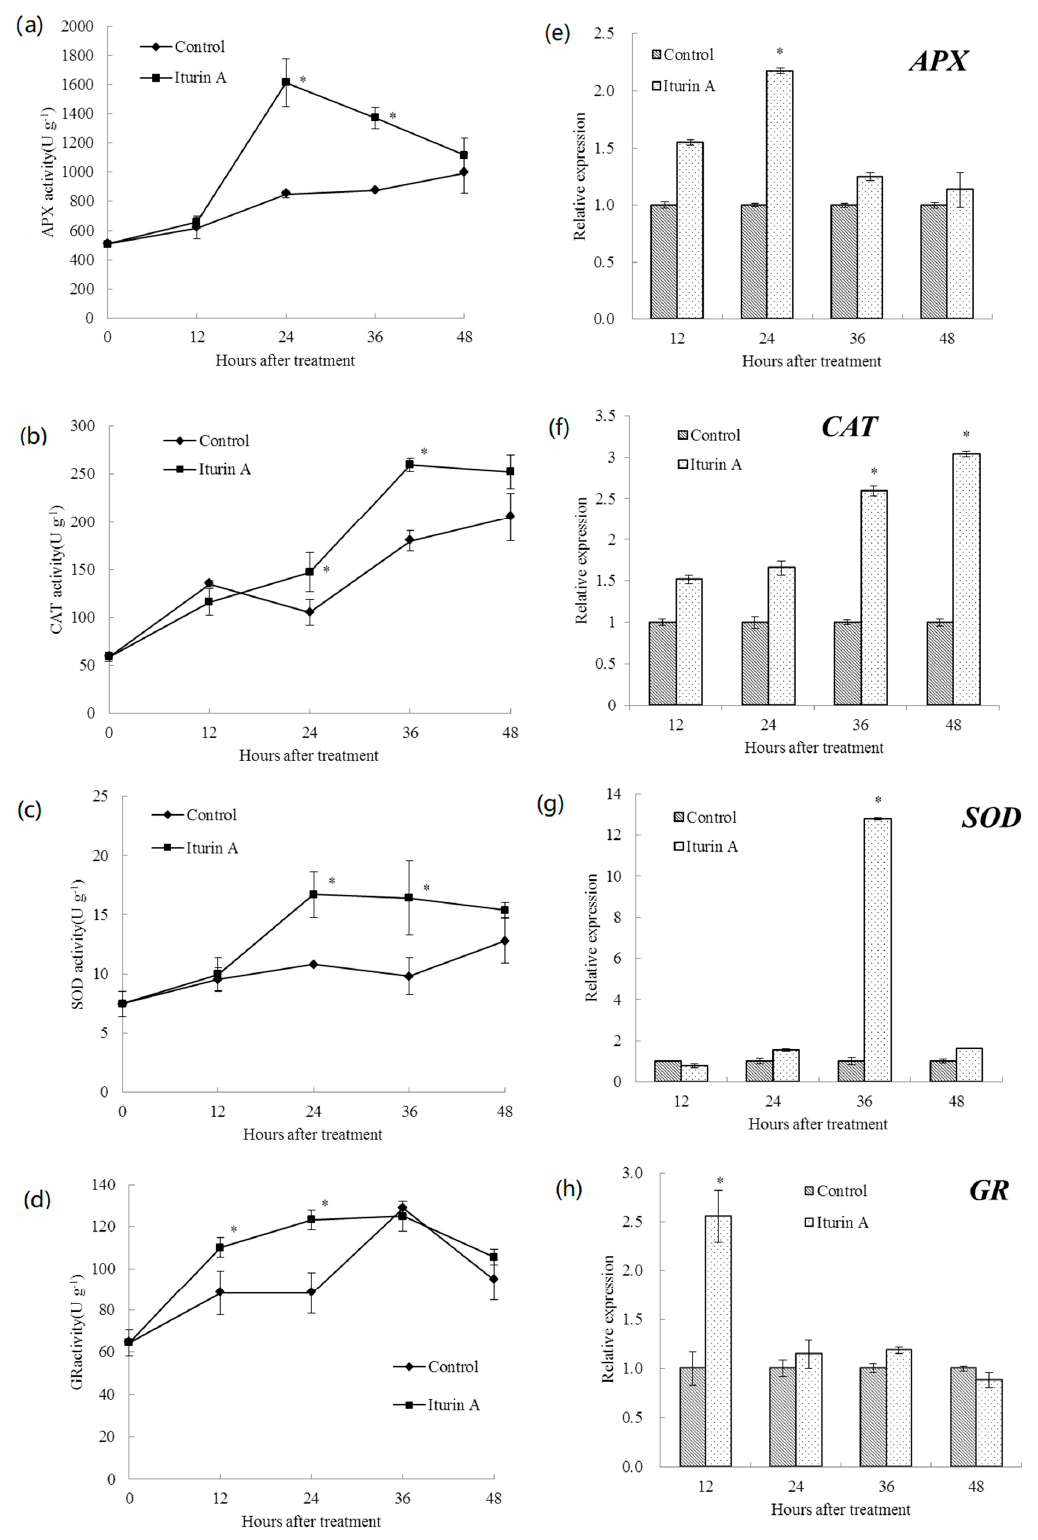
Figure 4. Activities of APX ( a ), CAT ( b ), SOD ( c ), and GR ( d ) and relative expression levels of APX ( e ), CAT ( f ), SOD ( g ), and GR ( h ) in cherry tomato fruit after treatment with sterile distilled water (control) and 512 µ g/mL of iturin A. The vertical bar represents the standard error for three replicate samples and asterisks (*) represent significant differences between the iturinA treatment and the control by the unpaired t -test ( p <